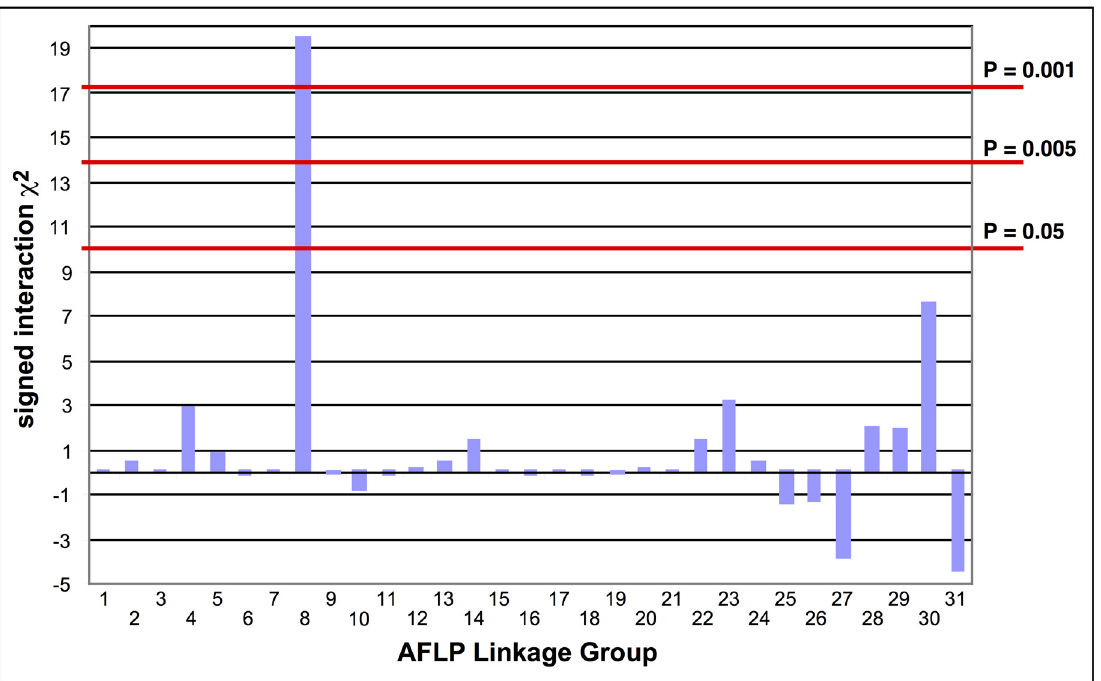
Fig 1. Tests of the association of AFLP linkage groups with Cry2Ab1 resistance in a bioassay of backcross progeny. The signed interaction χ 2 value shows the positive or negative association of the AFLP linkage group from the resistant grandparent with resistance in the progeny. Horizontal lines depict the Bonferroni-corrected probability values of P = 0.05, P = 0.005, and P = 0.001. Only AFLP linkage group 8 shows a significant positive association with